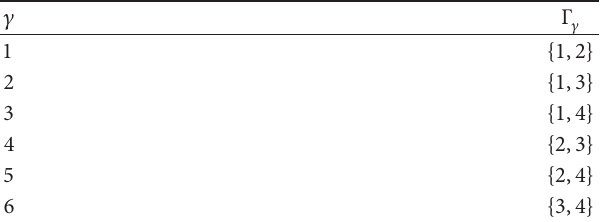
Table 1: Antenna subsets ( 𝑛 𝑇 = 4 , 𝑛 𝐷 = 2 , and Γ = 6